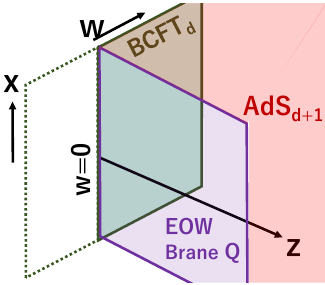
Figure 1 . A sketch of AdS/BCFT construction. The gravity dual of a BCFT is given by the red colored region which is surrounded by the boundary where the BCFT is situated (blown colored) and the end of the world-brane (EOW brane, purple